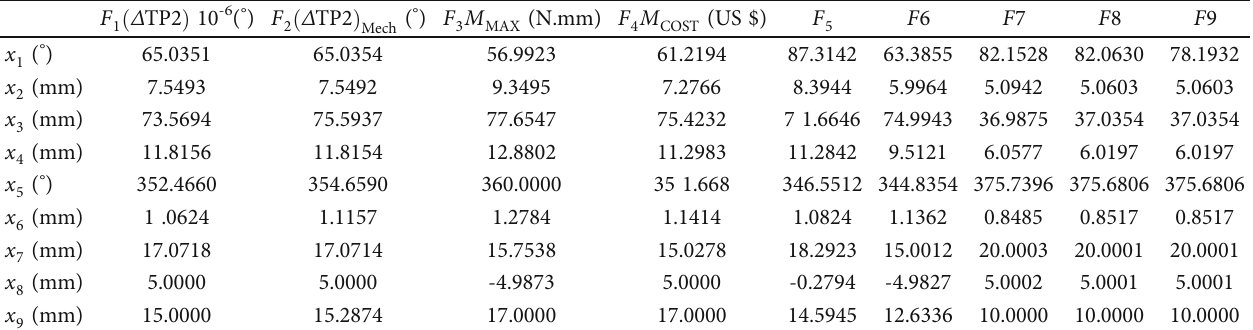
Table 4: Thumb optimum design variables versus optimization problem.